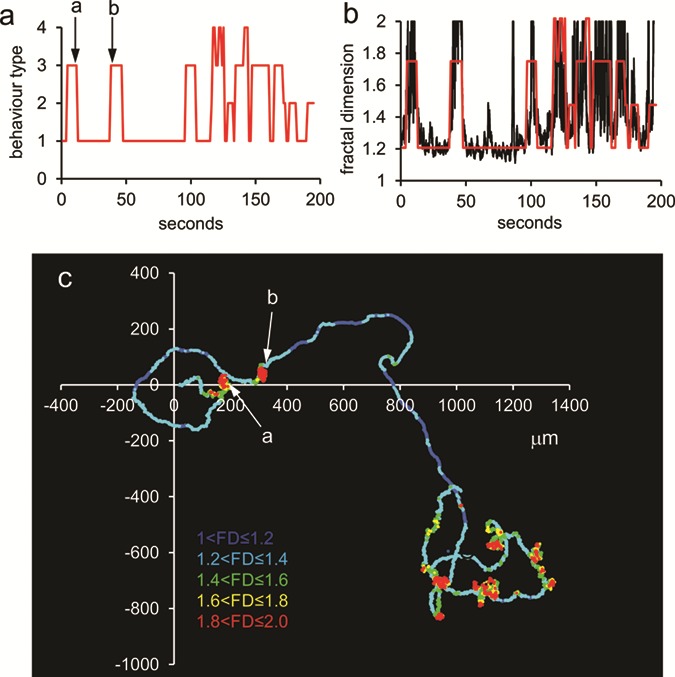

Behavioural switching in a free-swimming human sperm under control conditions (pH
o = 7.4). (a) Variation in behaviour type (categorised visually as type1, type 2, type 3 or type 4; see Supplementary
Figure S1) of a single sperm over a period of 190 s. (b) Variation in fractal dimension (FD) over time (black trace) overlaid with the visually categorised behaviour types (red trace). Visual analysis and FD show good agreement, with no visually identified behavioural transitions that are not confirmed by FD. (c) Track of the same cell, colour coded to display variation in the fractal dimension (FD); (1 < FD ≤ 1.2 (dark blue); 1.2 < FD ≤ 1.4 (light blue); 1.4 < FD ≤ 1.6 (green); 1.6 < FD ≤ 1.8 (yellow); 1.8 < FD ≤ 2.0 (red)). Axes show distance in μm.